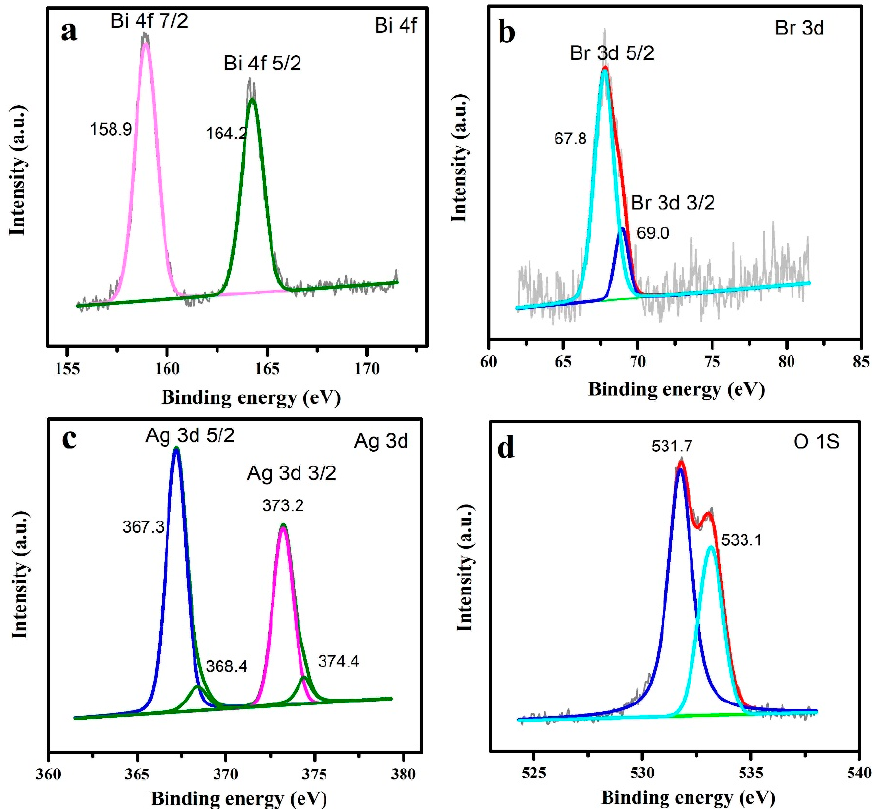
Figure 2. X-ray photoelectron spectroscopy (XPS) spectra of the AgBr / BiOBr / PAN CMs-2: ( a ) Bi 4f; ( b ) Br 3d; ( c ) Ag 3d; and ( d ) O 1s.